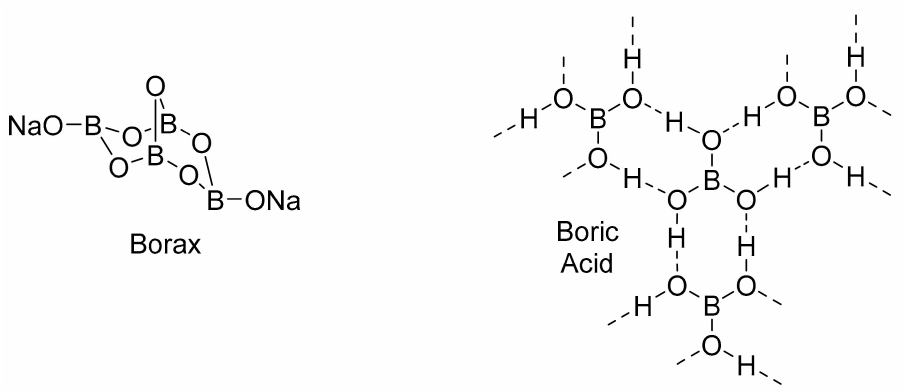
Figure 2. The earliest boron medicinal agents, borax, and boric